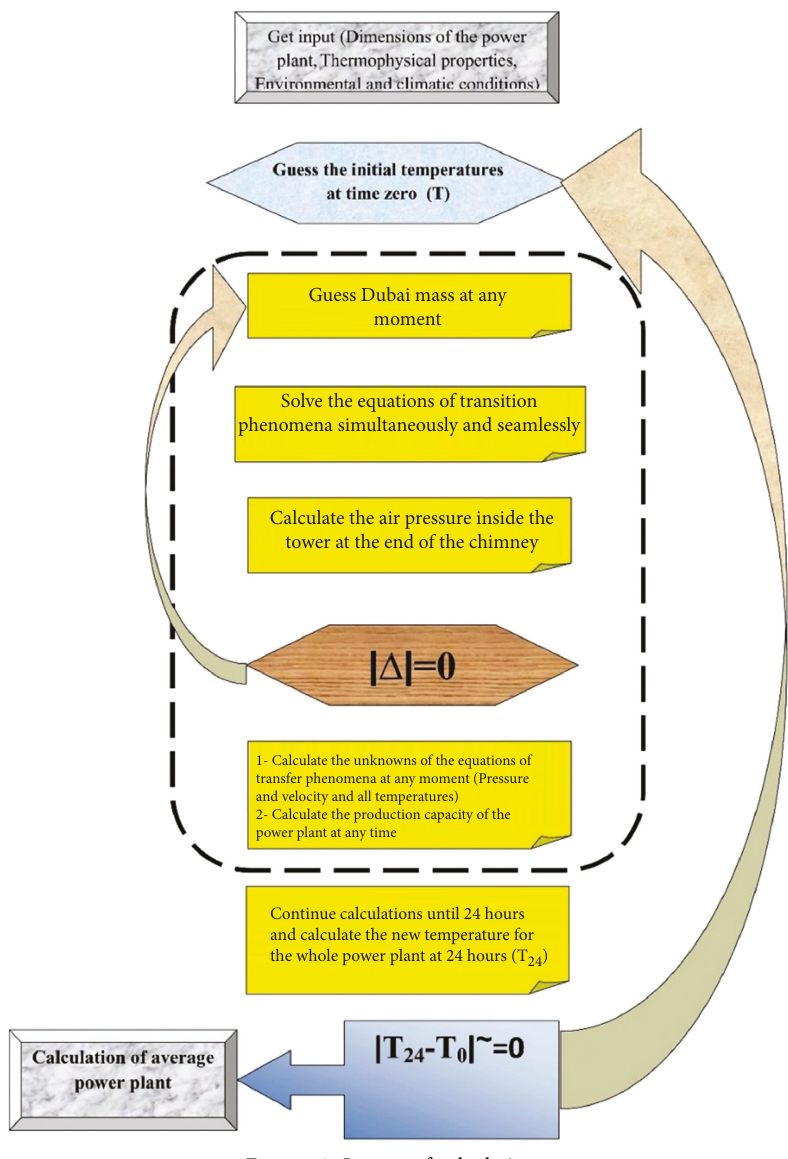
Figure 2: Layout of